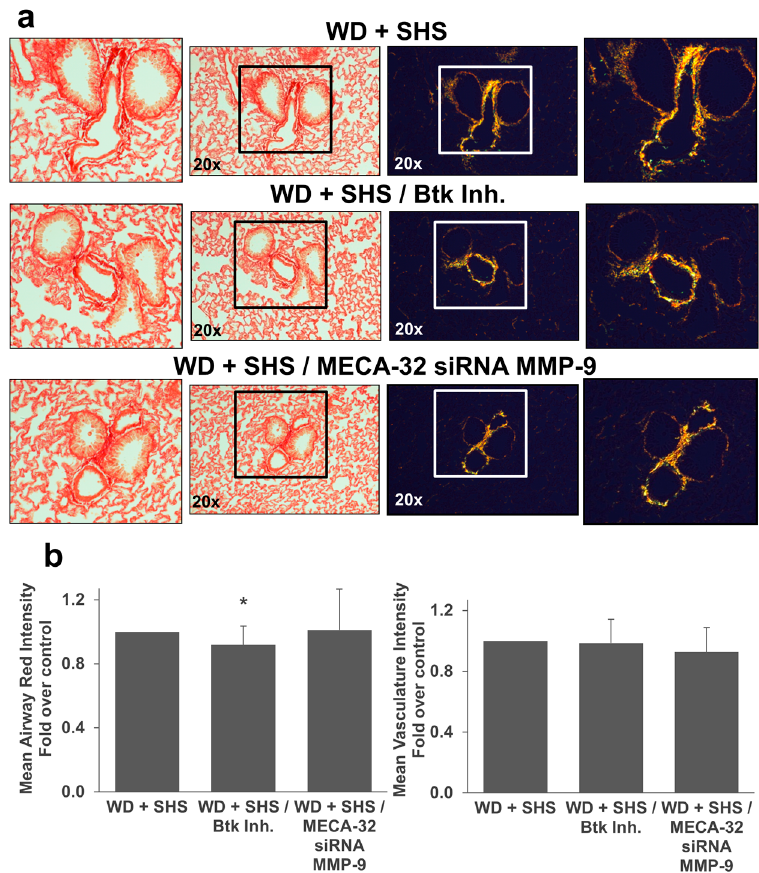
Figure 7. Collagen deposition in lungs of ApoE − / − mice fed WD and exposed to SHS only (WD + SHS), with Btk inhibitor treatment (WD + SHS/Btk Inh.), or treated with endothelial cell targeted siRNA for MMP-9 (WD + SHS/MECA32 siRNA MMP-9). Picro-sirius red stained lung sections from ApoE − / − mice were viewed under regular light (left panels) or polarized light (right panels). Representative images are shown ( a ). Differences in hue of Picro-sirius red stained airways were evaluated using ImageJ software. Results are expressed as mean red component intensities (airway) or mean total intensity (vasculature) ( b ). Btk inhibition or EC targeted MMP-9 specific siRNA impacted collagen deposition in the airways or lung vasculature respectively. Kruskal-Wallis ANOVA on ranks was used to assess statistical significance in red intensity between groups ( p < 0.081). As Dunn’s multiple comparison test was not possible we assessed the reduction observed in the Btk inhibitor treated group using the non-parametric Mann-Whitney test with Bonferroni correction for multiple comparisons ( p = 0.019). For mean vascular intensity one way ANOVA was used to assess differences between groups ( p = 0.227) and as Fishers least significant difference test was not possible, we assessed the reduction observed in the MECA-32 siRNA MMP-9 treated group using Student’s t -test with Bonferroni correction for multiple comparison ( p = 0.097), four to six animals per group were evaluated, with two groups of control animals combined. * Significant difference detected.